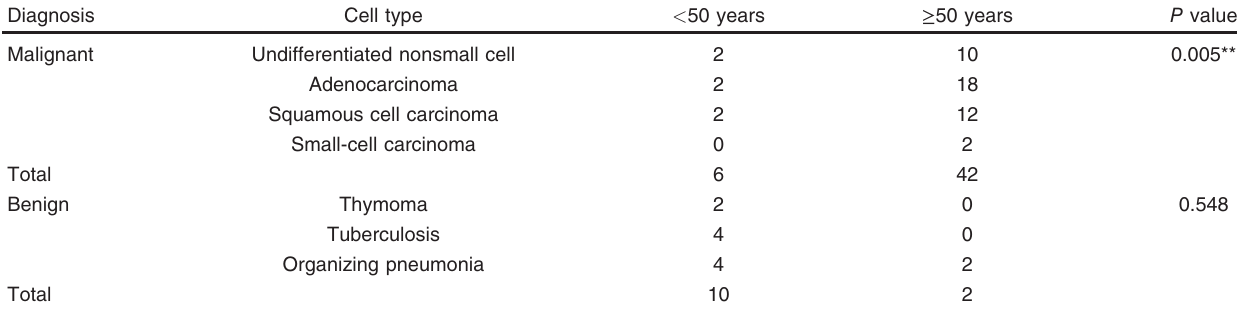
Table 5 Histopathological results in relation to age Diagnosis Cell type Malignant